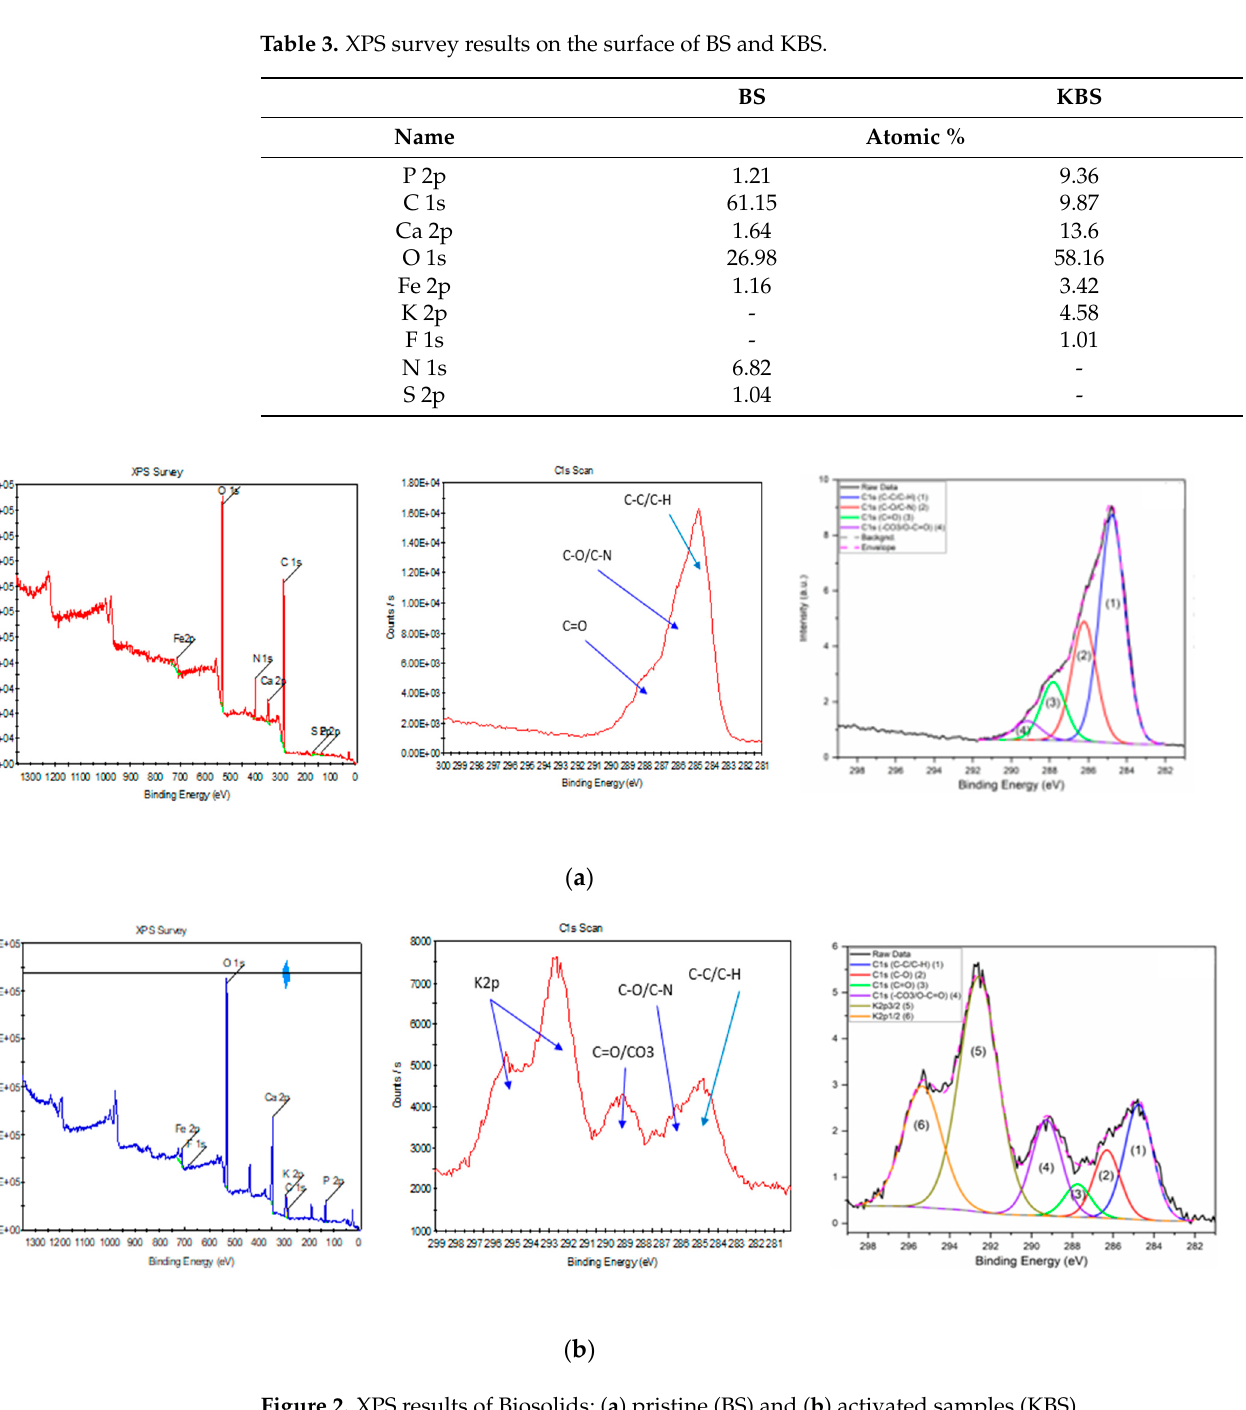
Figure 2. XPS results of Biosolids; ( a ) pristine (BS) and ( b ) activated samples (KBS) .